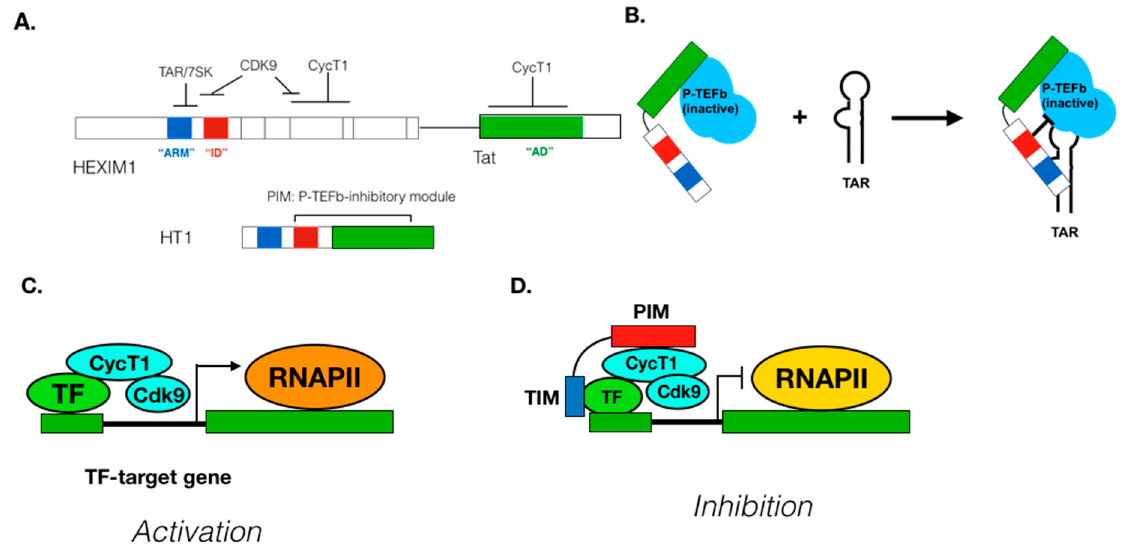
Figure 4. ( A ) Structure of the HEXIM1-Tat fusion peptides used. Functional domains used from HEXIM1 and Tat include a HEXIM1 Arginine-Rich Motif (ARM, blue box, residues 150–162) that binds to HIV TAR RNA, a HEXIM1 inhibitory domain (ID, red box, residues 200–211) that inhibits CDK9, and a Tat transactivation domain (AD, green box, residues 1–48) that binds to P-TEFb. ID and AD form a potent P-TEFb inhibitory motif (PIM). HT1 was constructed by fusing ARM and ID from HEXIM1 and AD from Tat. ( B ) A model for HT1’s inhibitory mechanism. HT1 recruits P-TEFb via AD to HIV’s Transactivation Response (TAR) element through the interaction between HT1’s ARM and TAR. HT1’s ID inhibits Cdk9’s kinase activity in the HT1 / P-TEFb / TAR complex, blocking HIV transcriptional elongation. ( C ) Transcription factor (TF)-specific recruitment of P-TEFb to its target genes. Various DNA-bound and unbound TFs (green oval) directly interact with P-TEFb to recruit it